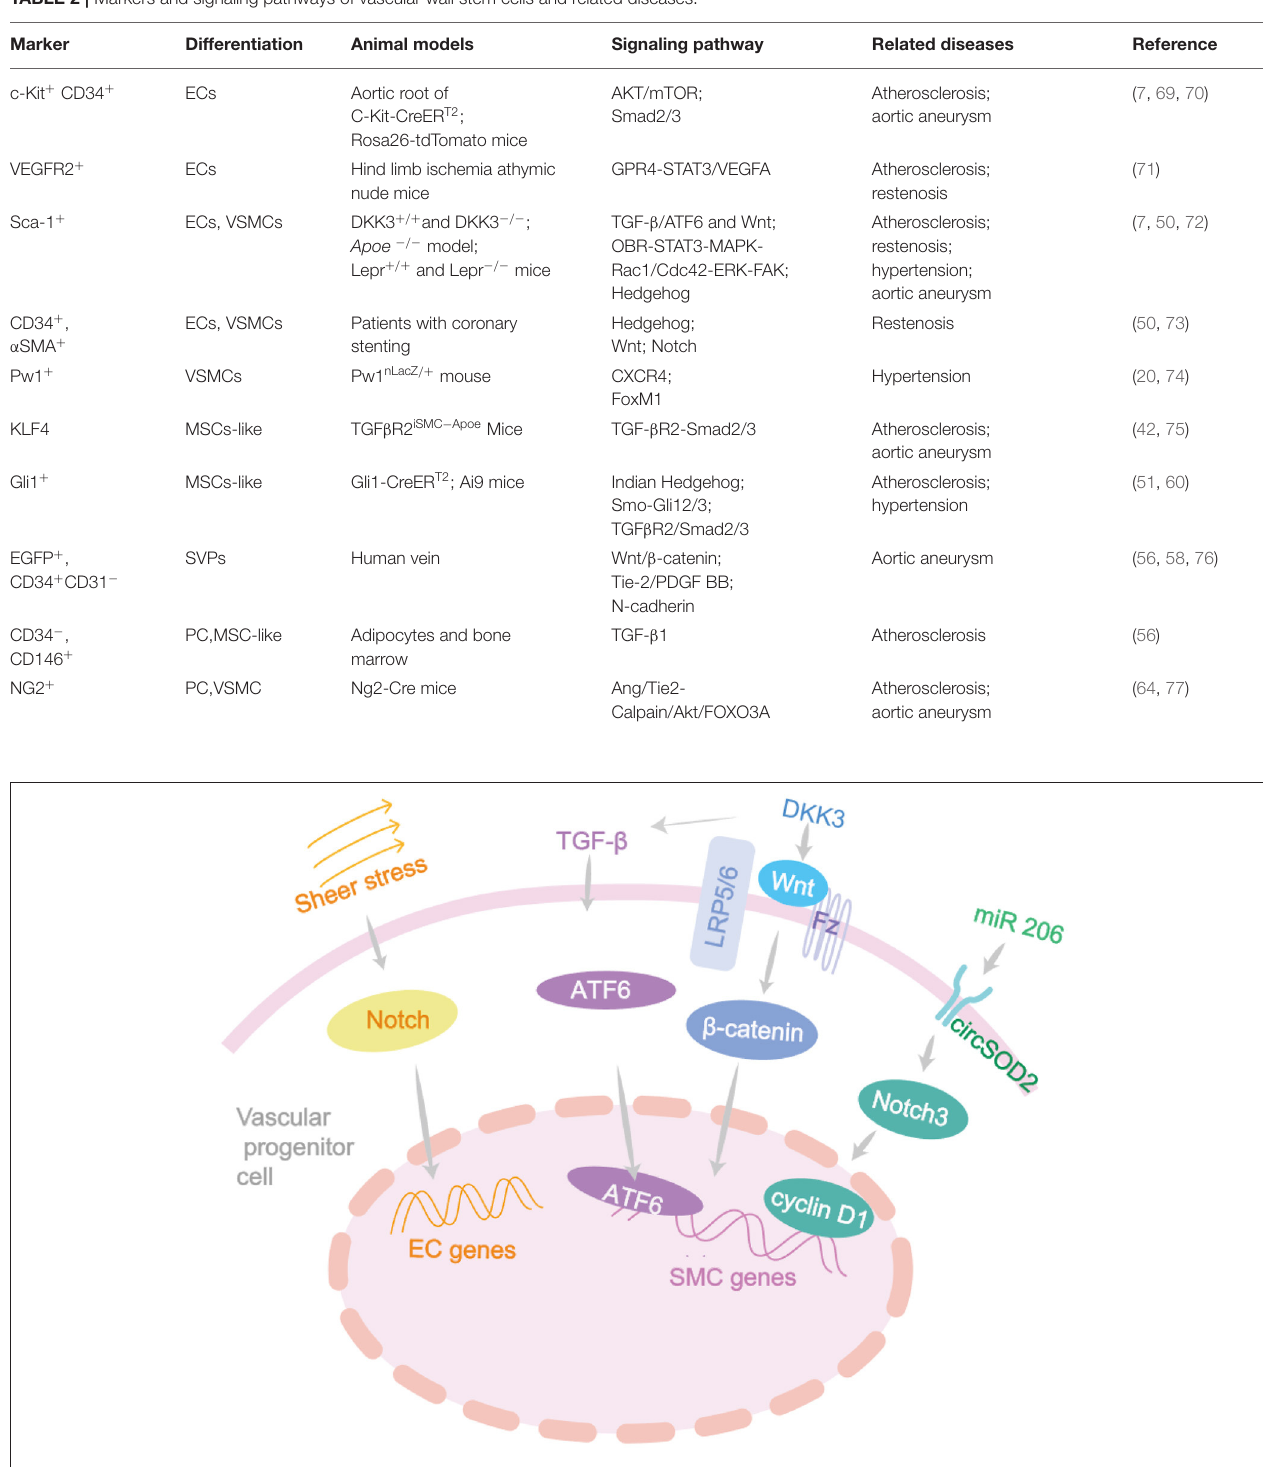
FIGURE 2 | The differentiation signaling pathway of vascular progenitor cells. Vascular development and remodeling depend on many genes and are usually initiated by fluid shear stress which acts on the Notch signaling and closely associated with the vascular remodeling diseases. DKK3 induces ECs migration through Wnt-PCP signaling pathway, accelerating re-endothelialization, and reducing neointima formation. DKK3 can induce the differentiation of Sca-1 + progenitor cells and fibroblasts into VSMC by activating TGF- β /ATF6 signaling pathways.